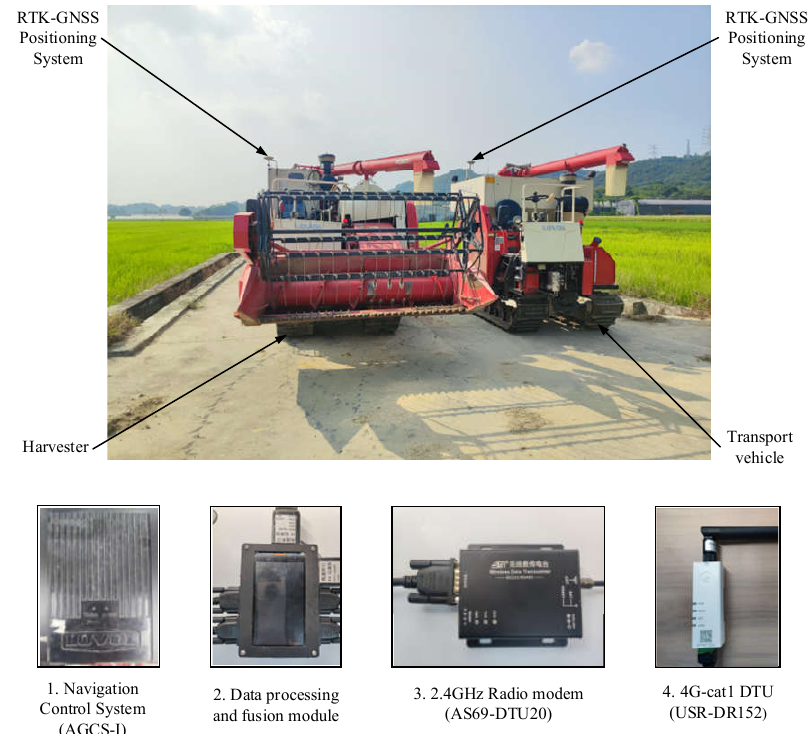
Figure 6. Inter-vehicle communication test scene of collaborative harvest system.